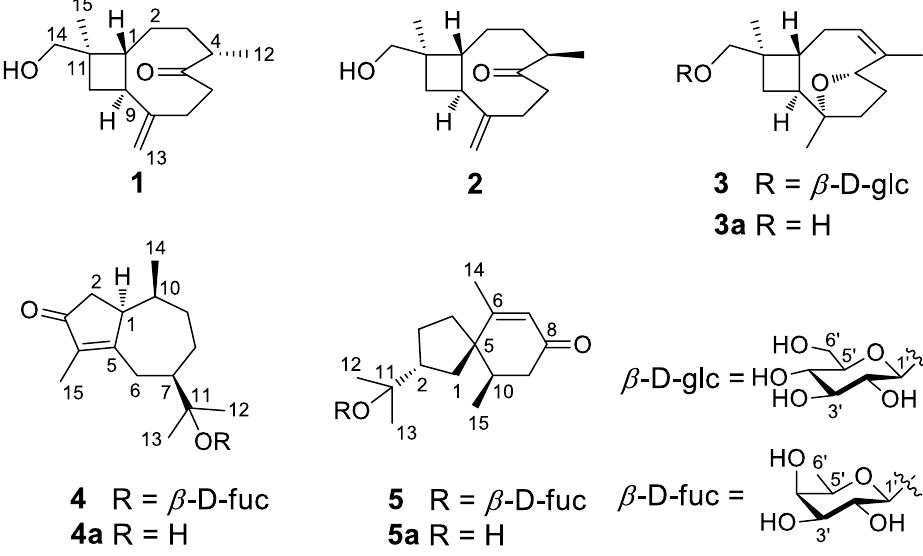
Figure 1. Structures of compounds 1 – 5 and 3a – 5a